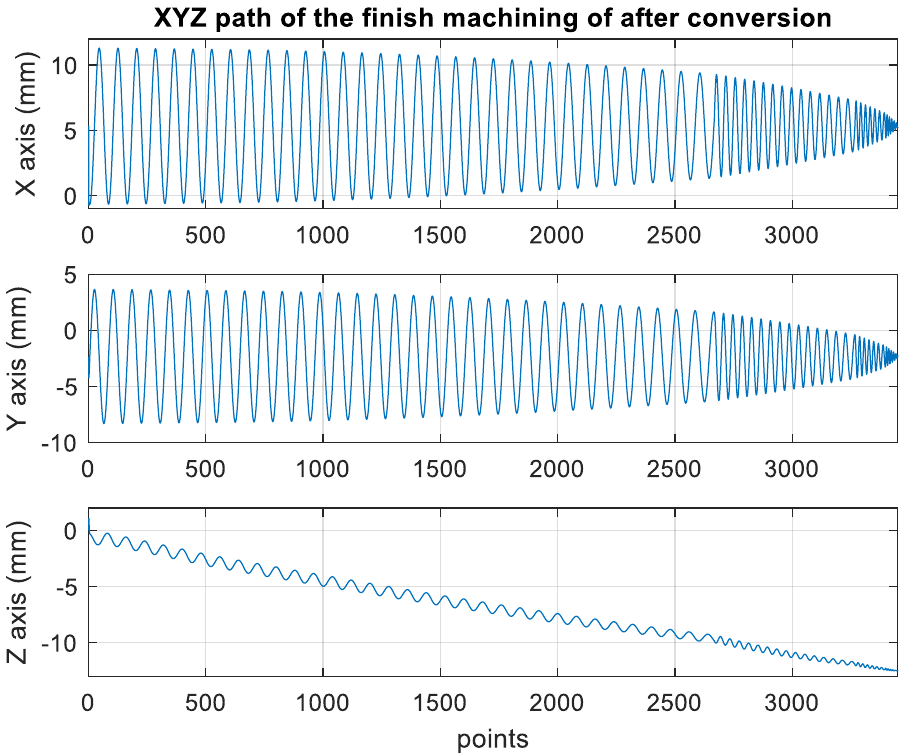
Figure 22. The path of the XYZ axis after converting the finish machining program.